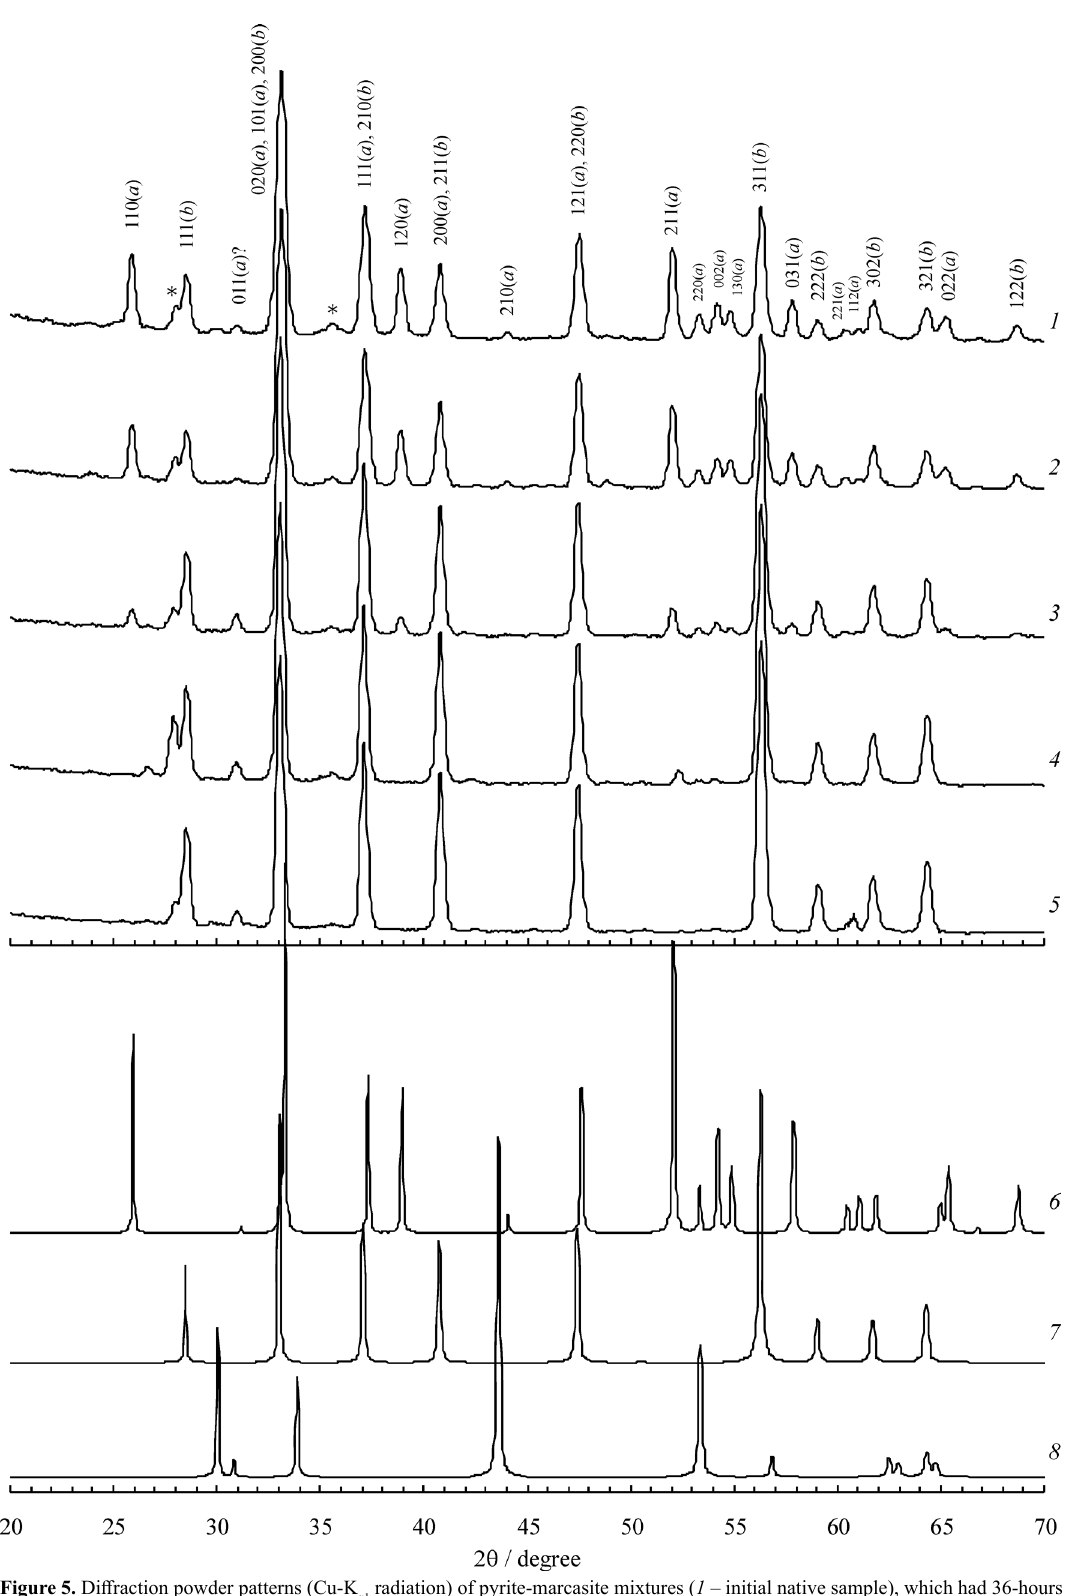
radiation) of pyrite-marcasite mixtures ( 1 – initial native sample), which had 36-hours Figure 5. Diffraction powder patterns (Cu-K α1 annealing under the KCl–FeCl eutectic melts at the following temperatures: 2 – 365; 3 – 400; 4 – 450; 5 – 500 ºC; а – marcasite 2 α-FeS , Pnnm ) peaks; b – pyrite (β-FeS , Pa 3 ) peaks; * – the notation for the silicates impurities. 6 – 8 – calculated powder pattern: 2 2 6 – marcasite α-FeS , 7 – pyrite β-FeS , 8 – pyrrhotite γ-Fe 2 2 1 ‒ x